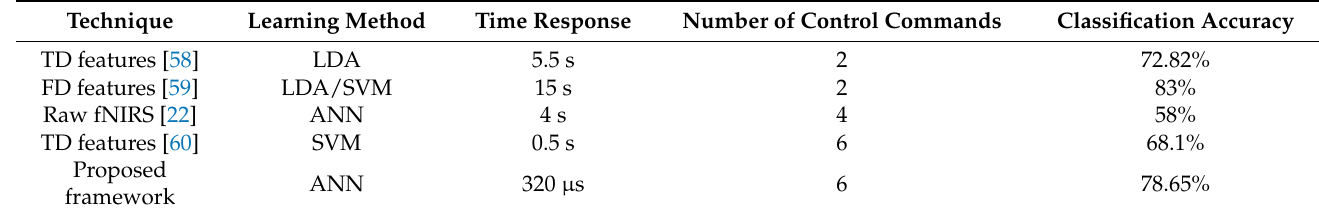
Table 4. Performance evaluation and comparison with existing classification